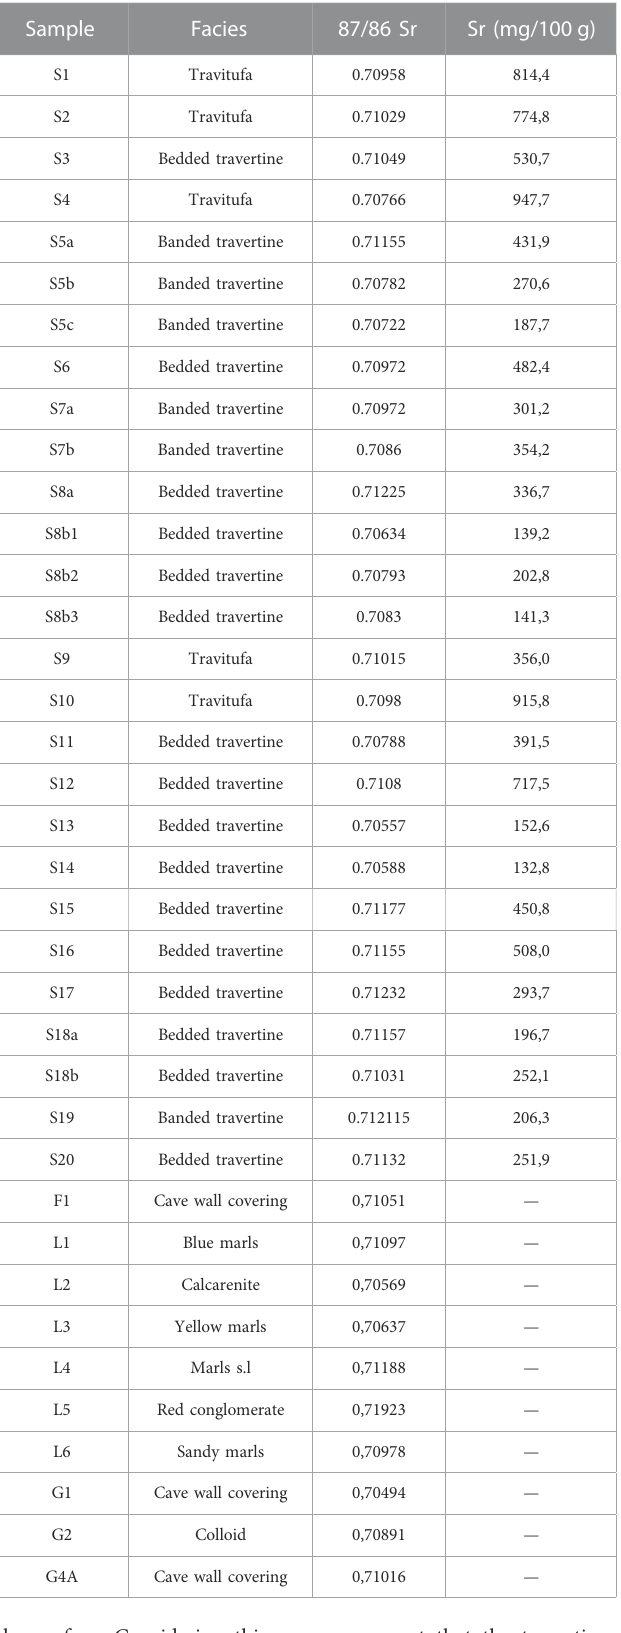
TABLE 5 87 Sr/ 86 Sr ratios and Sr content of the carbonates, and 87 Sr/ 86 Sr ratios of the cave deposits and Miocene sediments in Carraclaca site.